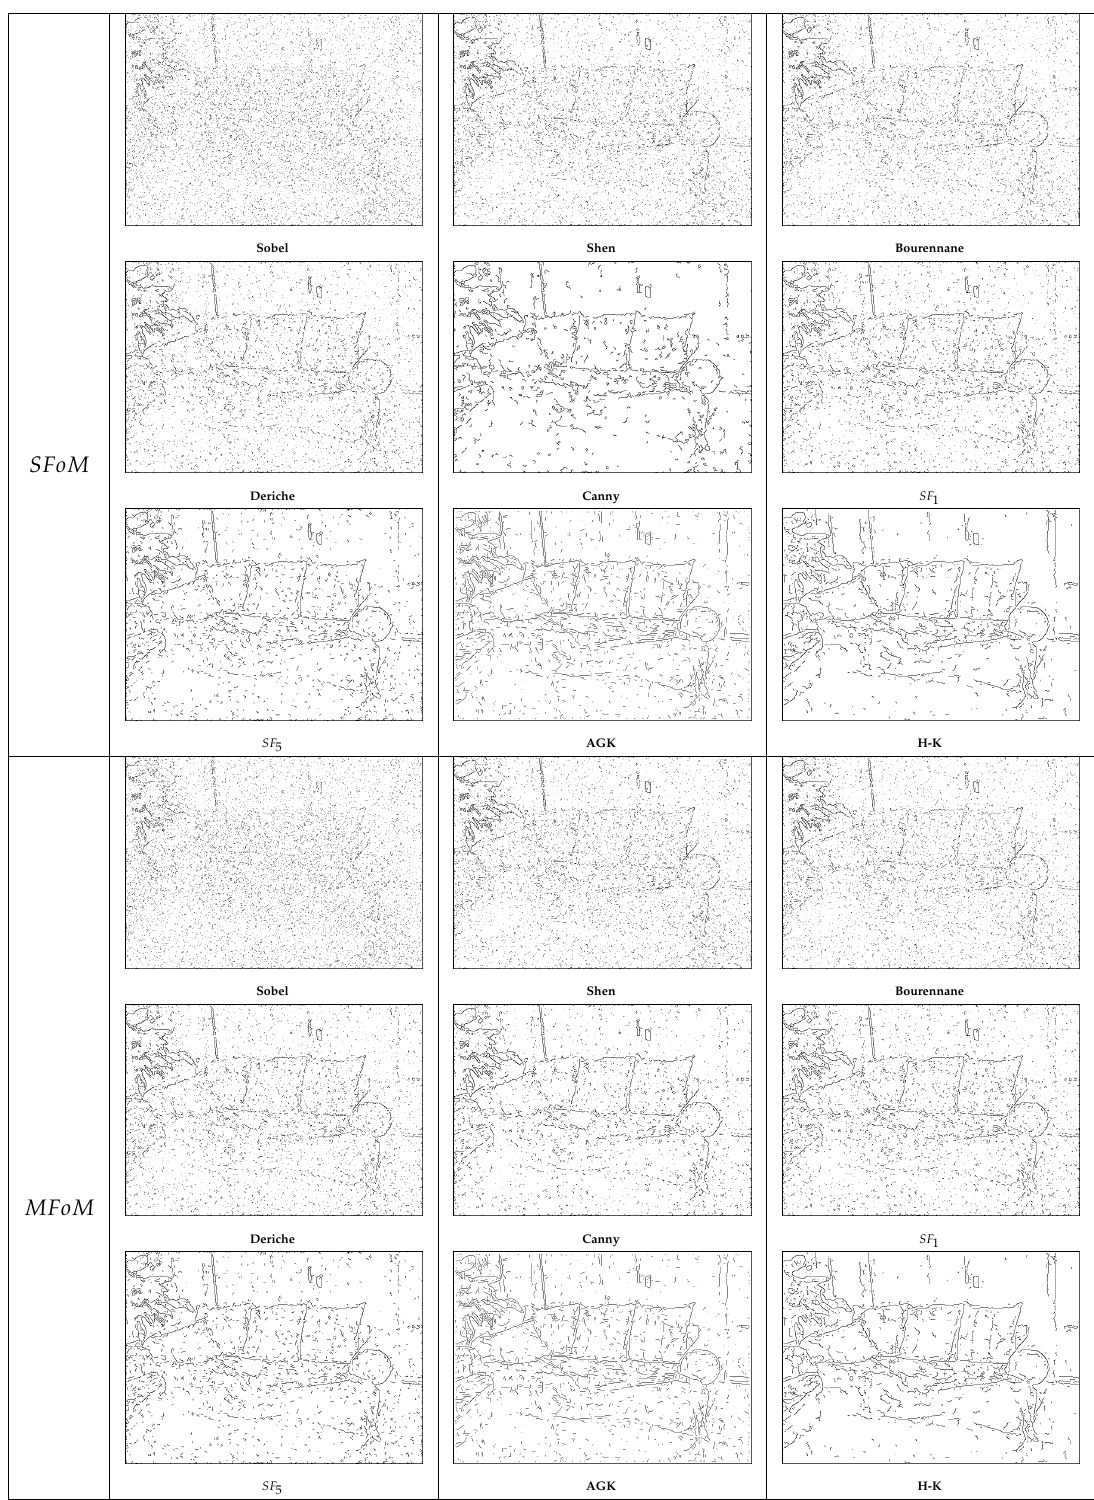
Figure 30. Ideal segmentations for several edge detectors on image 109, PSNR = 14